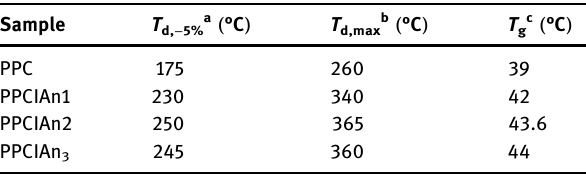
Table 2: Salient thermal parameters for PPC and PPCIAns